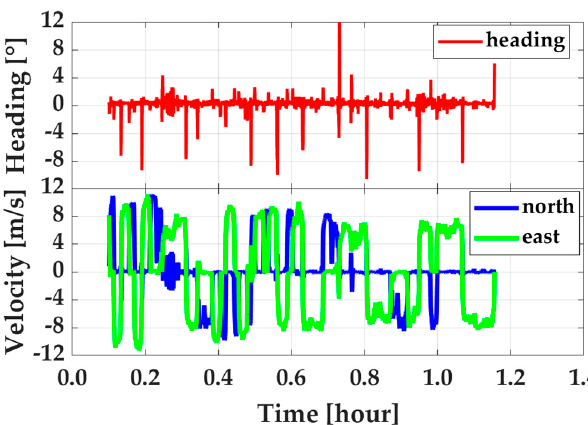
Figure 11. Heading angles calculated by velocity ( top ) from PPP and the corresponding velocity in horizontal ( bottom ).